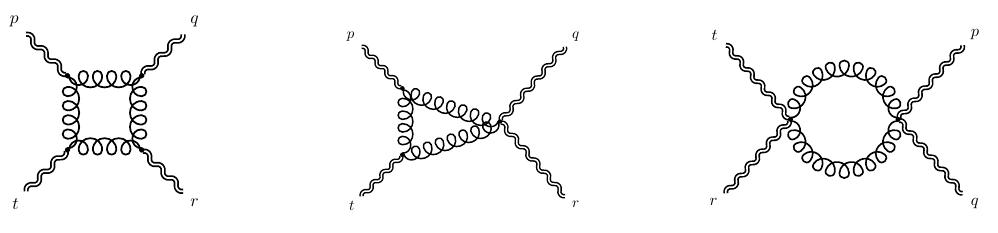
Figure 18 . The contribution (5.19) of a gauge-multiplet loop to the four-graviton amplitude contains box, triangle and bubble